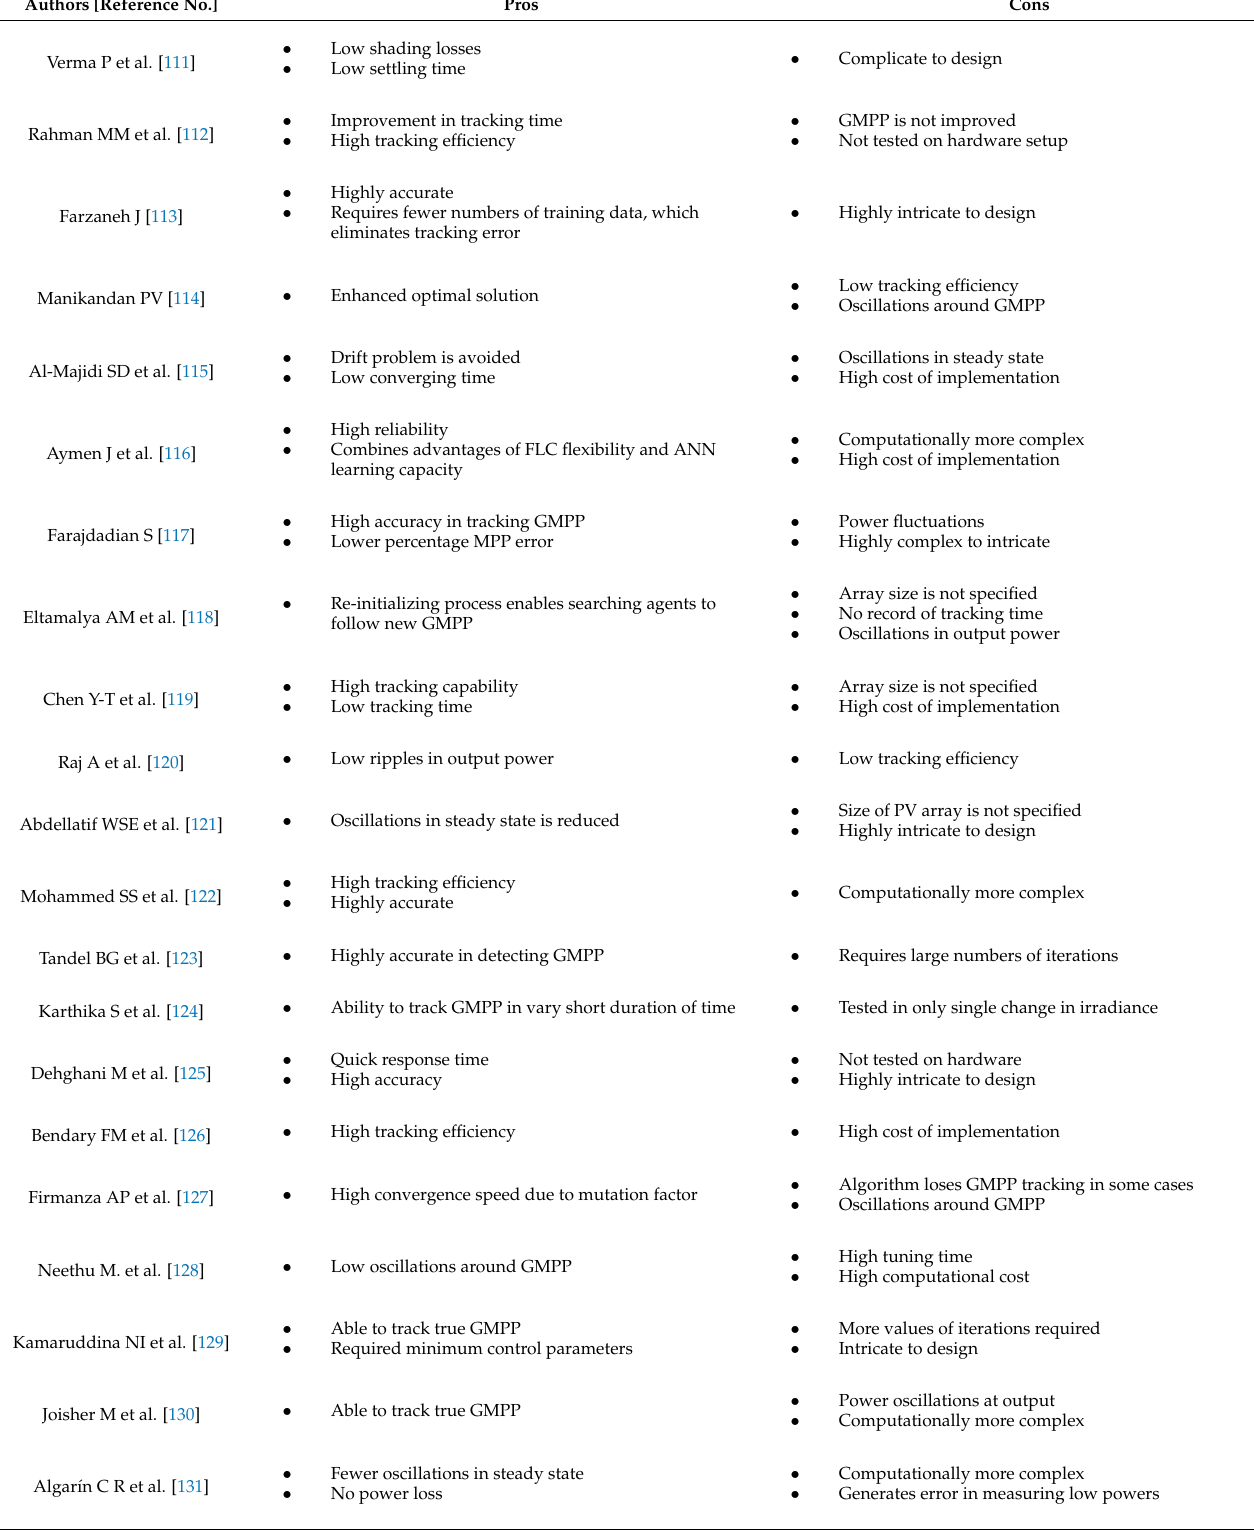
Table 8. Pros and cons of recent work based on other artificial intelligence